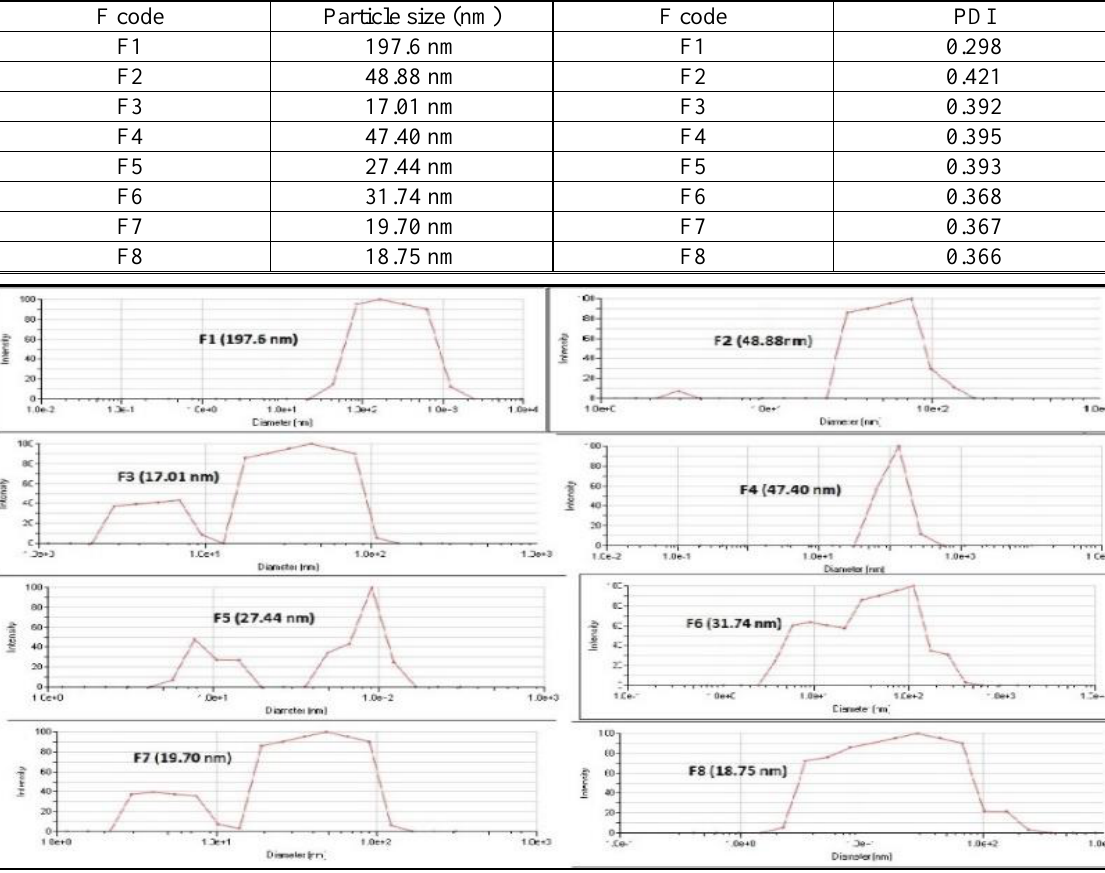
Figure 3.Particle size distribution of felodipine nanoemulsions. Transmittance percentage (%T)